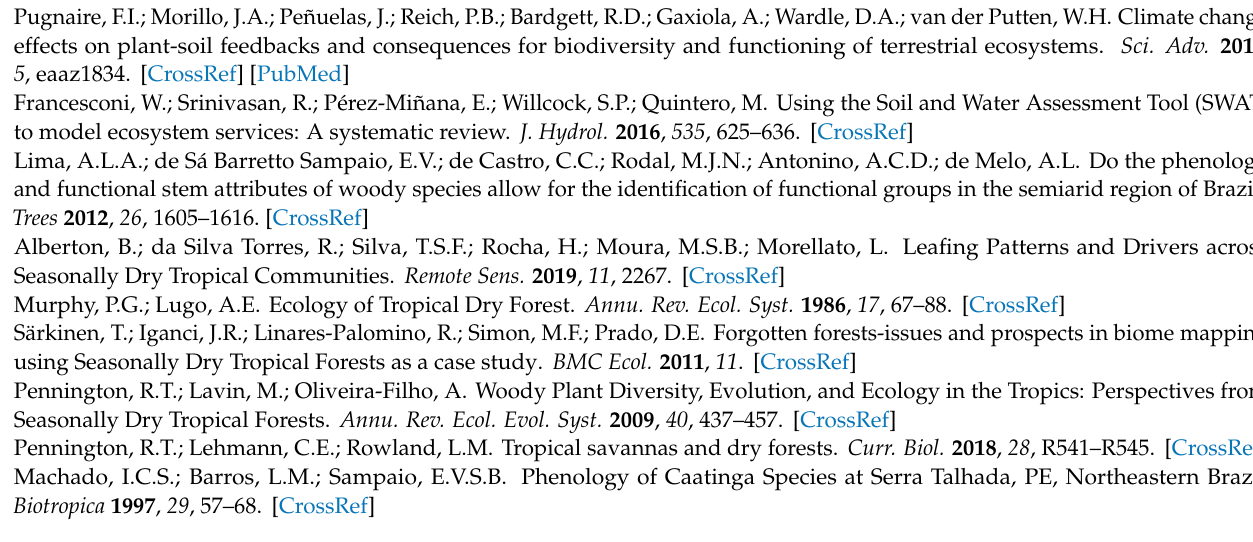
orbital VI. Figure S2: Community sap flow and phenological response: (A) Normalized sap flow for the plot community (F dnc , dimensionless), GCC S 2 and SAVI S 2 . (B) F dnc , NDVI modis and NDVI S 2